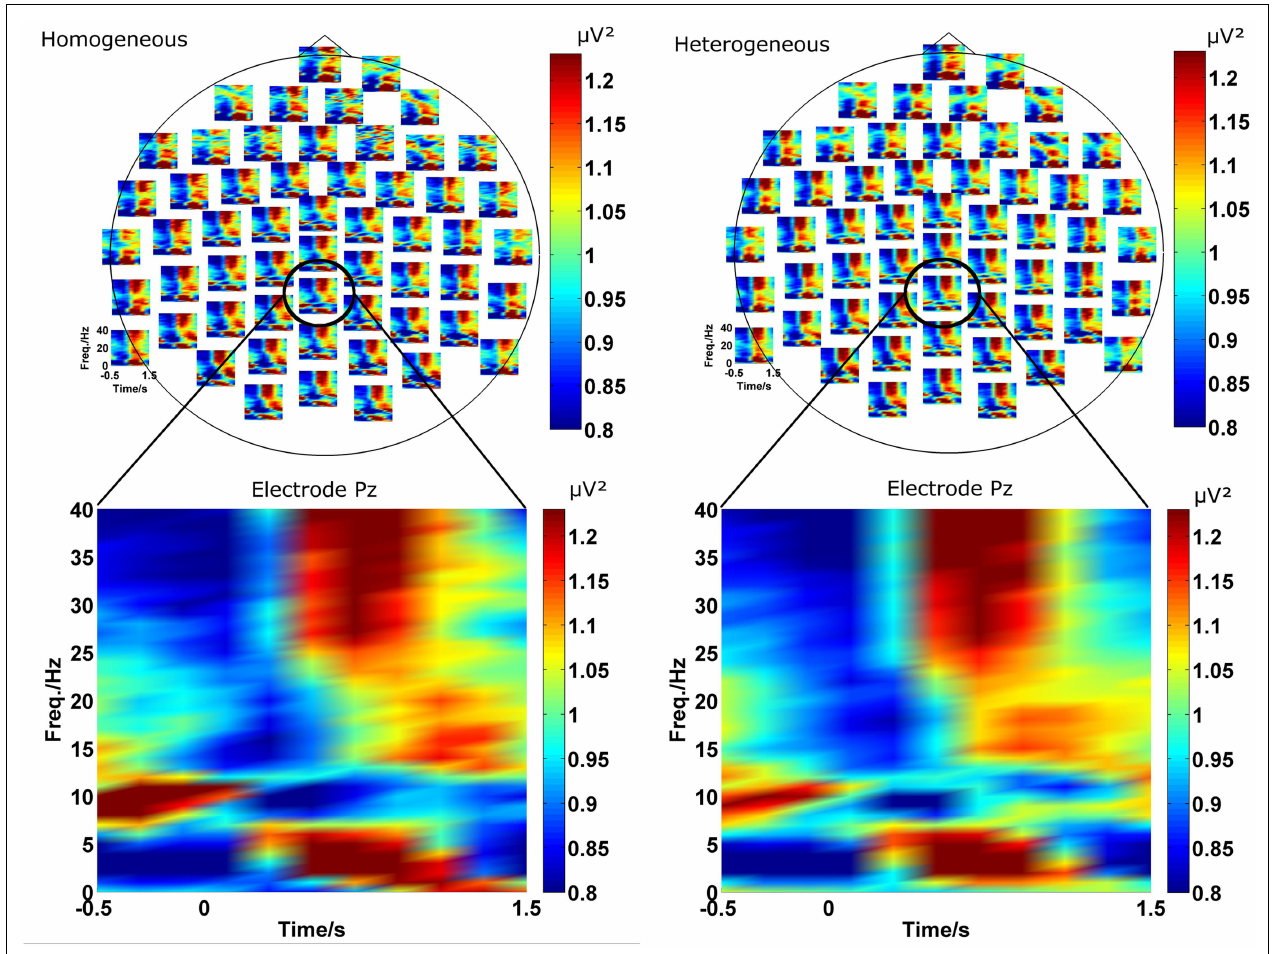
In both conditions ongoing oscillations in theta, alpha, beta, and gamma frequency bands evolving after stimulus onset can be observed. Furthermore, the spectrograms are similar in both